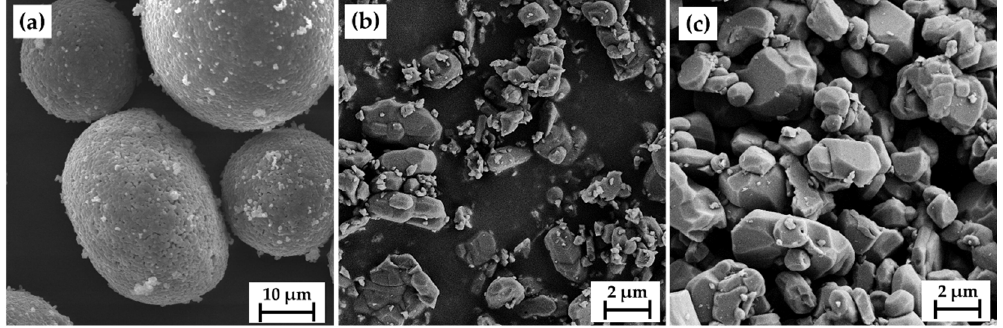
Figure 1. Morphologies of alumina feedstock powders used for spraying: ( a ) METCO 6103, ( b ) MZS-1, ( c ) dried powder of AuerCoat ® suspension.